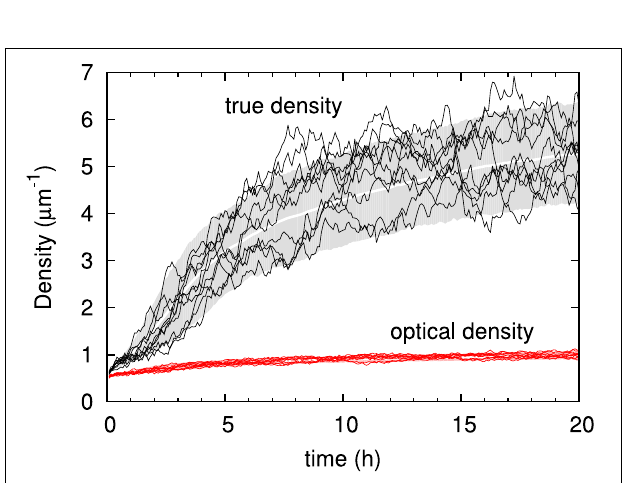
FIGURE 6 | 2D snapshots. Snapshots of configurations of a 2D system evolving over time from an initially empty state. Default parameters.